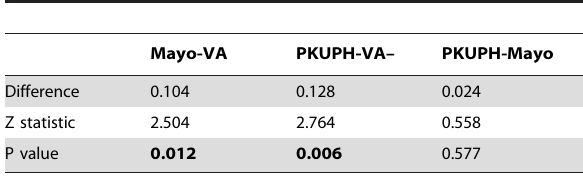
Table 6. Comparison of AUC values between different